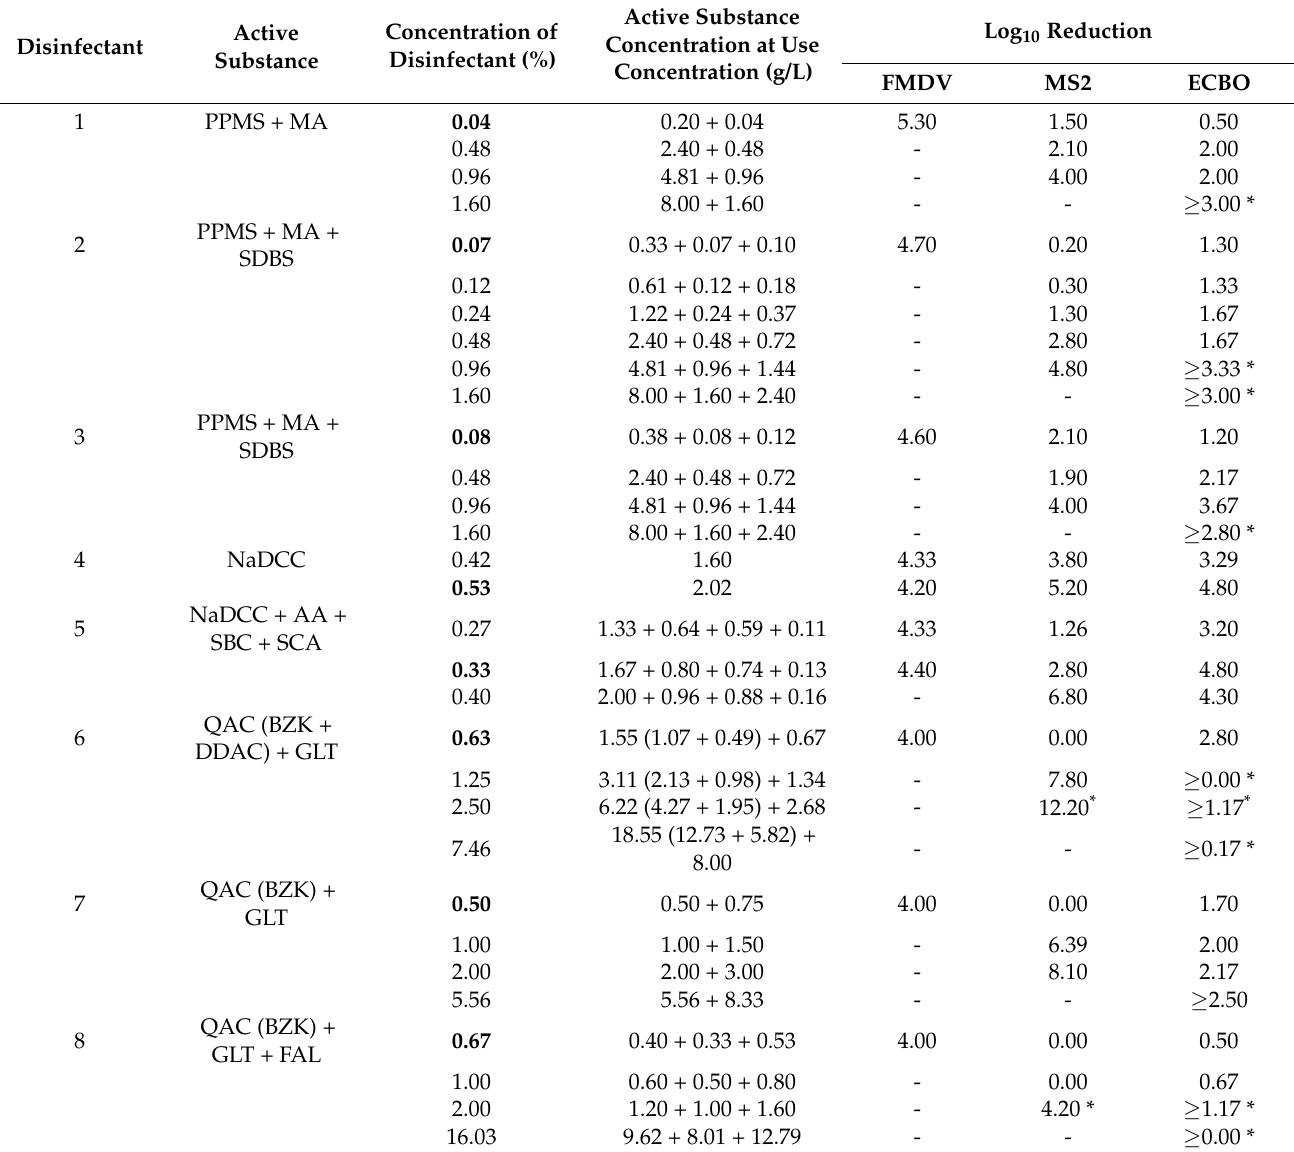
Table 4. Description and virucidal activity of commercial disinfectants tested against foot-and-mouth disease virus, bacteriophage MS2, and bovine enterovirus type